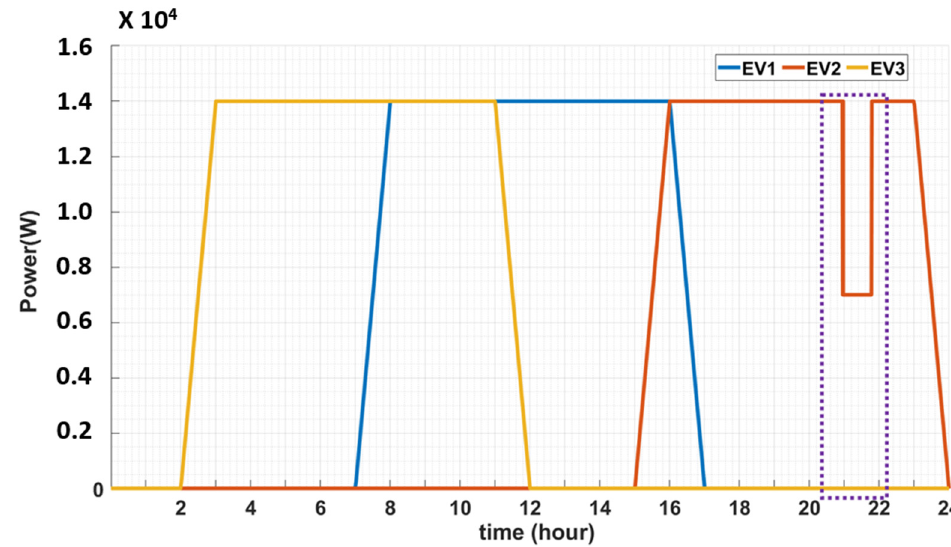
Figure 18. EV charging power according to 𝛾(𝑡) .